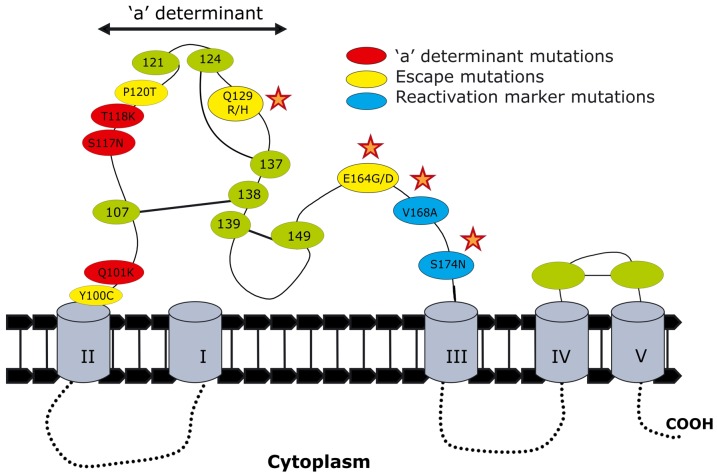
Graphic representation of mutations found within the small envelope protein of the HBV isolated from HIV infected participants.This is a hypothetical representation [91]. The mutations marked with a star occurred significantly more frequently in HBV isolated from HIV-co-infected individuals in this study than in strains of the same cluster of the phylogenetic tree (figure 1).